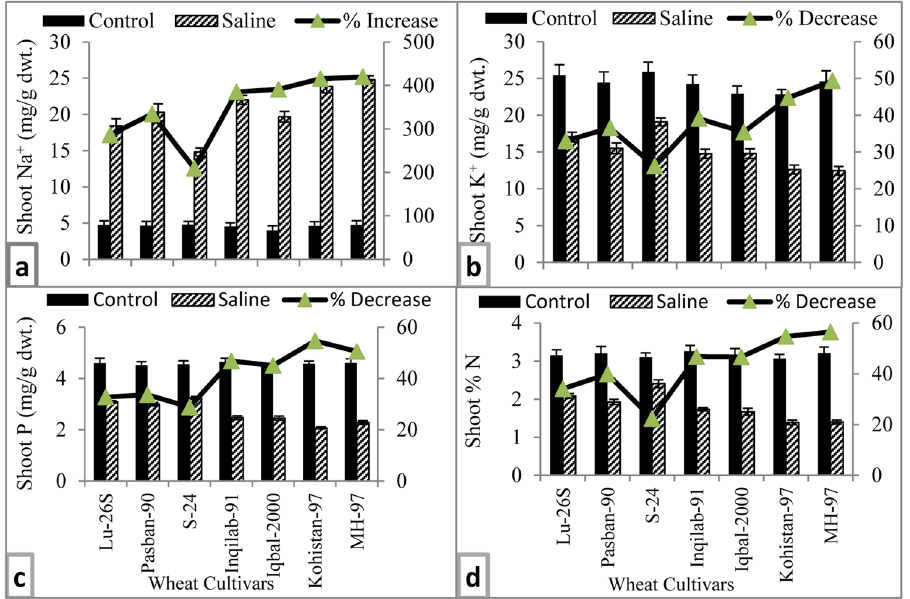
Figure 6. Inorganic solutes of selected salt tolerant and sensitive wheat cultivars at adult stage when plants of each cultivar were subjected to 0 or 150 mM NaCl salinity stress. Means are presented on primary vertical axis, while percent increase/decrease value is presented on secondary vertical